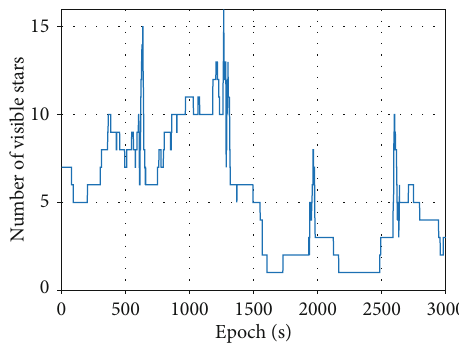
Figure 15: Number of visible stars in the fused